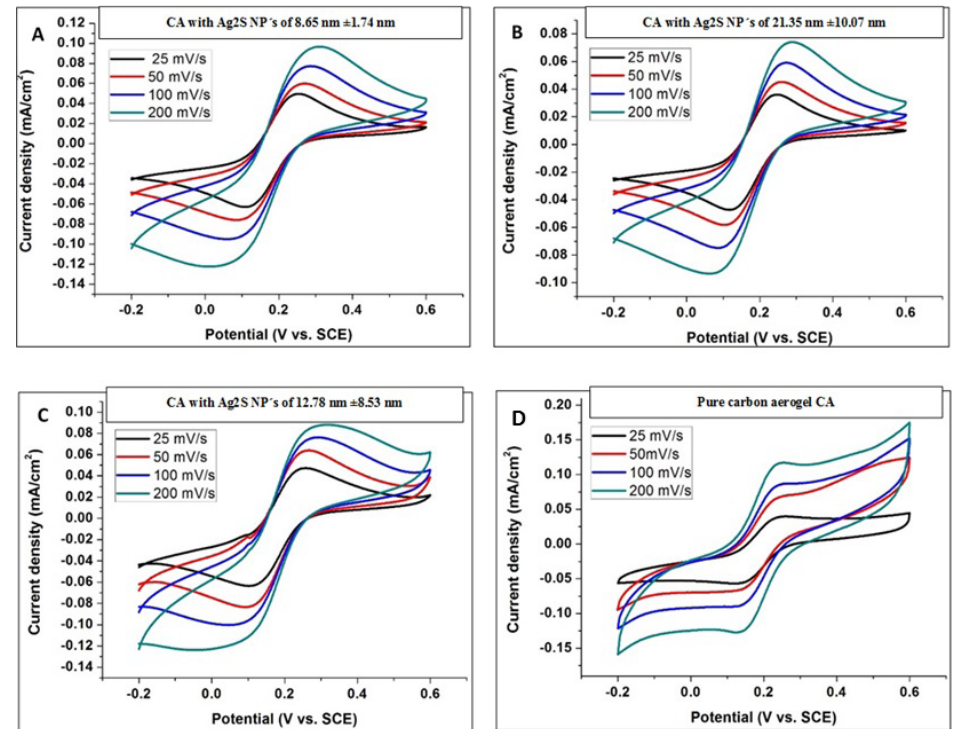
Figure 4. Cyclic voltammetry of the synthesized electrodes and pure carbon aerogel.